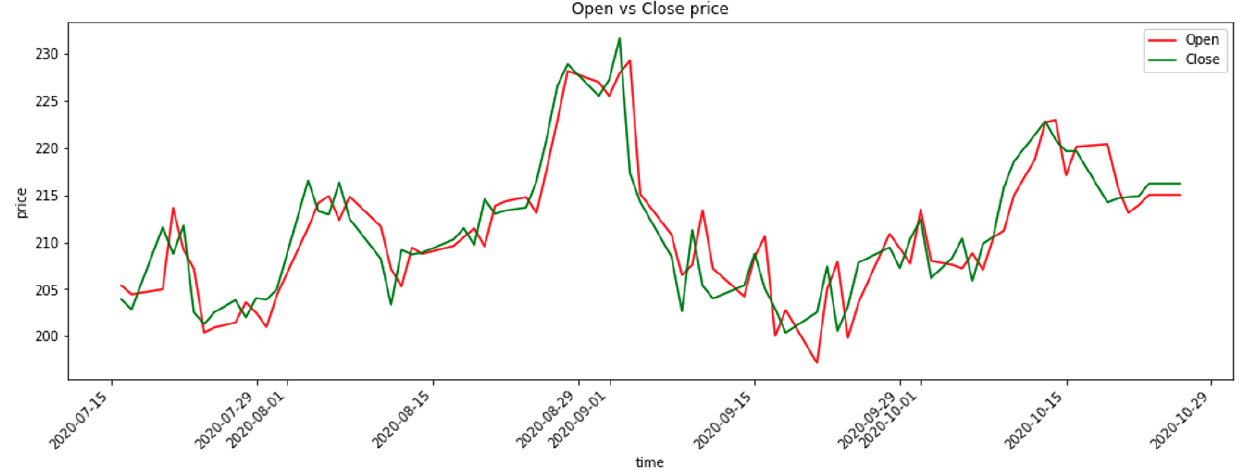
Figure 2. Microsoft stock open and close